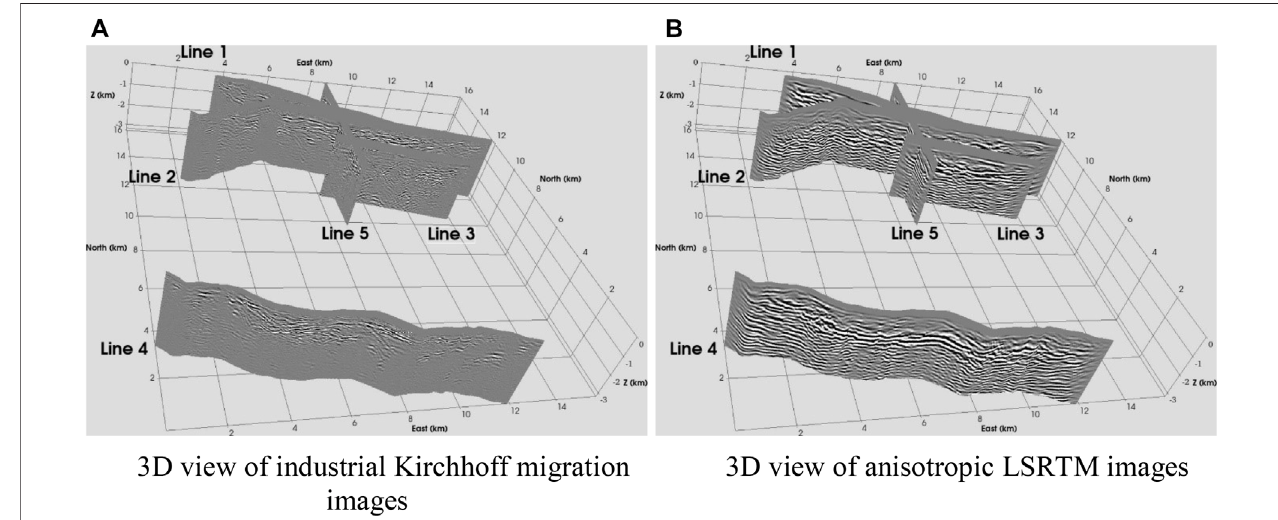
FIGURE 15 | Comparison between 3D views of industrial Kirchhoff migration (left) and our anisotropic LSRTM migration (right) . Anisotropic LSRTM reveals high- resolutionsubsurfaceimages along fi veseismic surveylines at Pirouette Mountain and Eleven-Mile Canyon thatcanbe usedtoidentify faultsforgeothermalexploration. (A) 3D view of industrial Kirchhoff migration images. (B) 3D view of anisotropic LSRTM